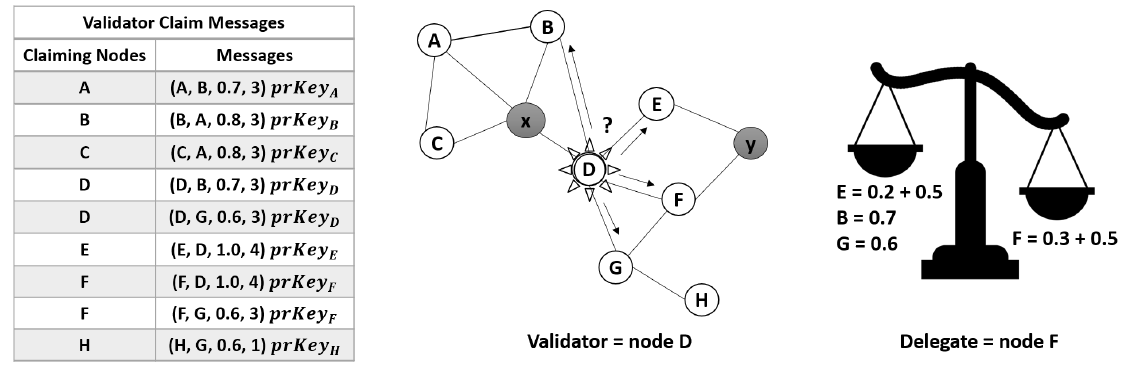
Figure 7. Demonstration of Phase